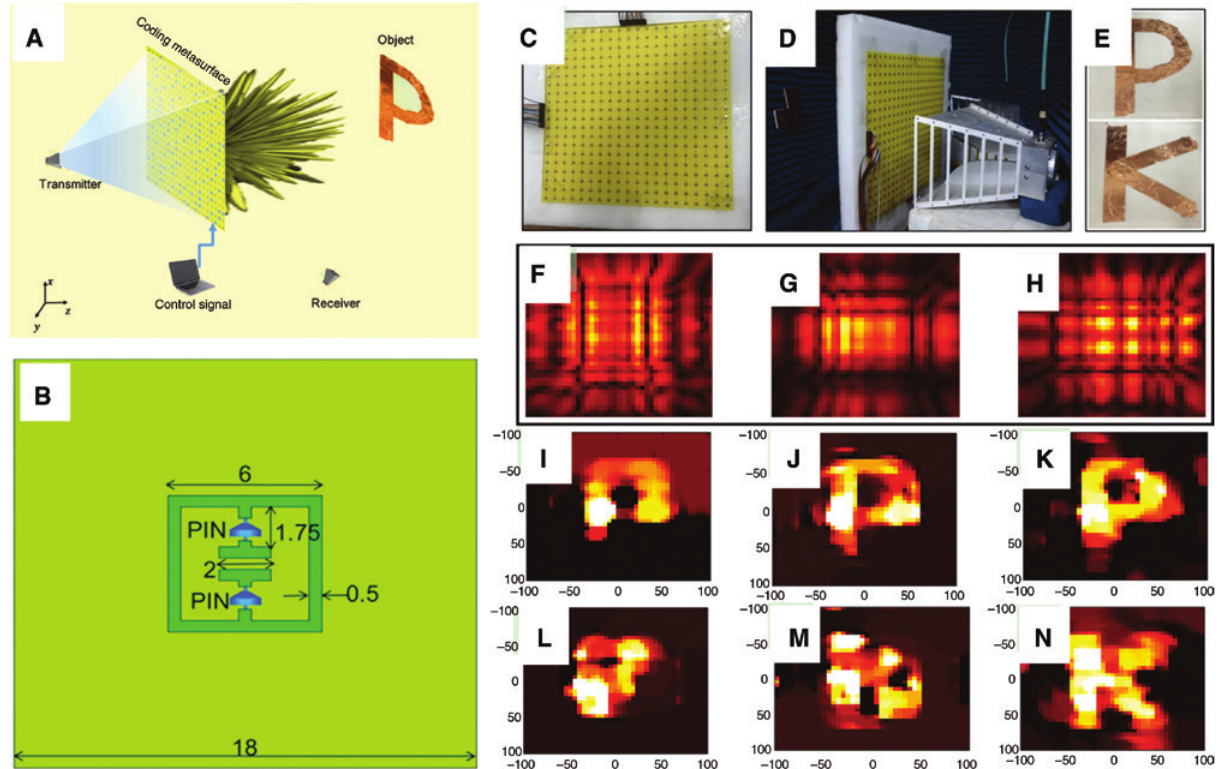
Figure 10: Programmable imager based on the 1-bit transmission-type information metasurface. (A) The schematic map of the imager. (B) The configuration for the voltage-controlled meta atom. Each meta atom behaves as a “1” when the loaded diode is ON, and as “0” when the diode is OFF. (C) The fabricated sample of the column-row-wise information metasurface. (D) Experimental setup. (E) “P”- and “K”-shaped metallic objects for imaging test. (F)–(H) Three samples of near-field radiation patterns of information metasurface. (I)–(K) The experimental imaging results for the “P”-shaped metallic object with different measurement numbers M = 200, 400 and 600, respectively. (L)–(N) Experimental imaging results for the “K”-shaped metallic object with different measurement numbers M = 200, 400, and 600, respectively. Adapted from